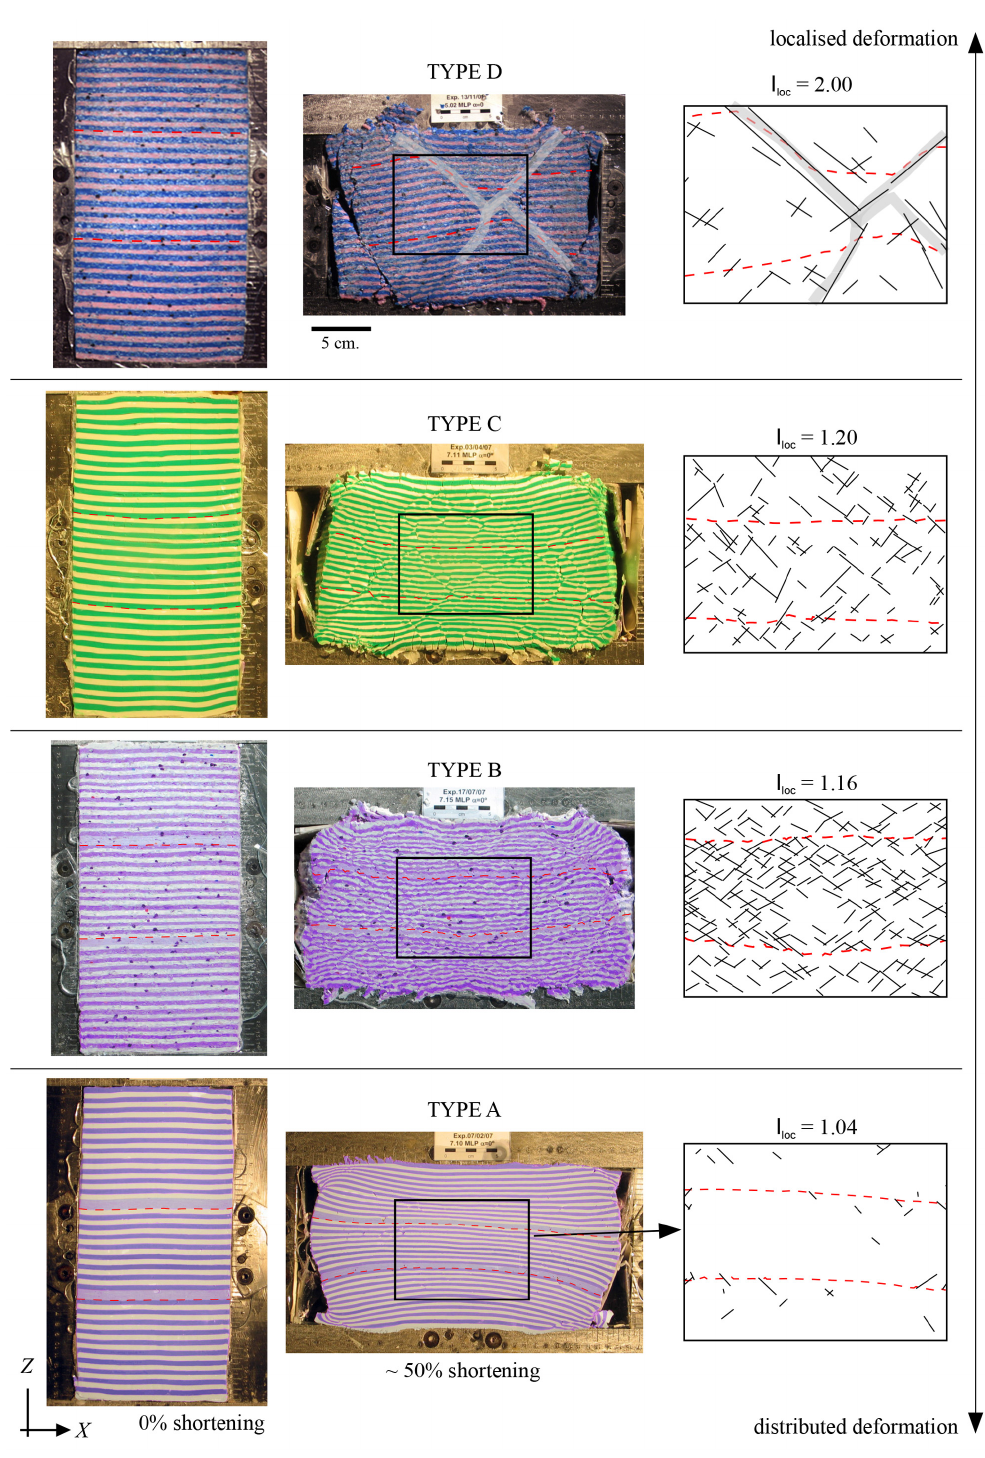
Figure 5. Photographs of the initial (0% shortening) and final ( ∼ 50% shortening) stages of the four multilayer models. Maps of analysed fracture networks are displayed on the right side. Red dashed lines indicate reference layers. Grey shadowed areas in type D model show the location of large fault zones. Only structures located in the central area of each model, indicated with a rectangle, are systematically studied. I loc is the localisation factor (see Sect. 2.2). The degree of localisation progressively increases from model A to model D and depends on the strength, effective viscosity and degree of anisotropy of the models. Marked differences between the resulting fracture networks can be clearly